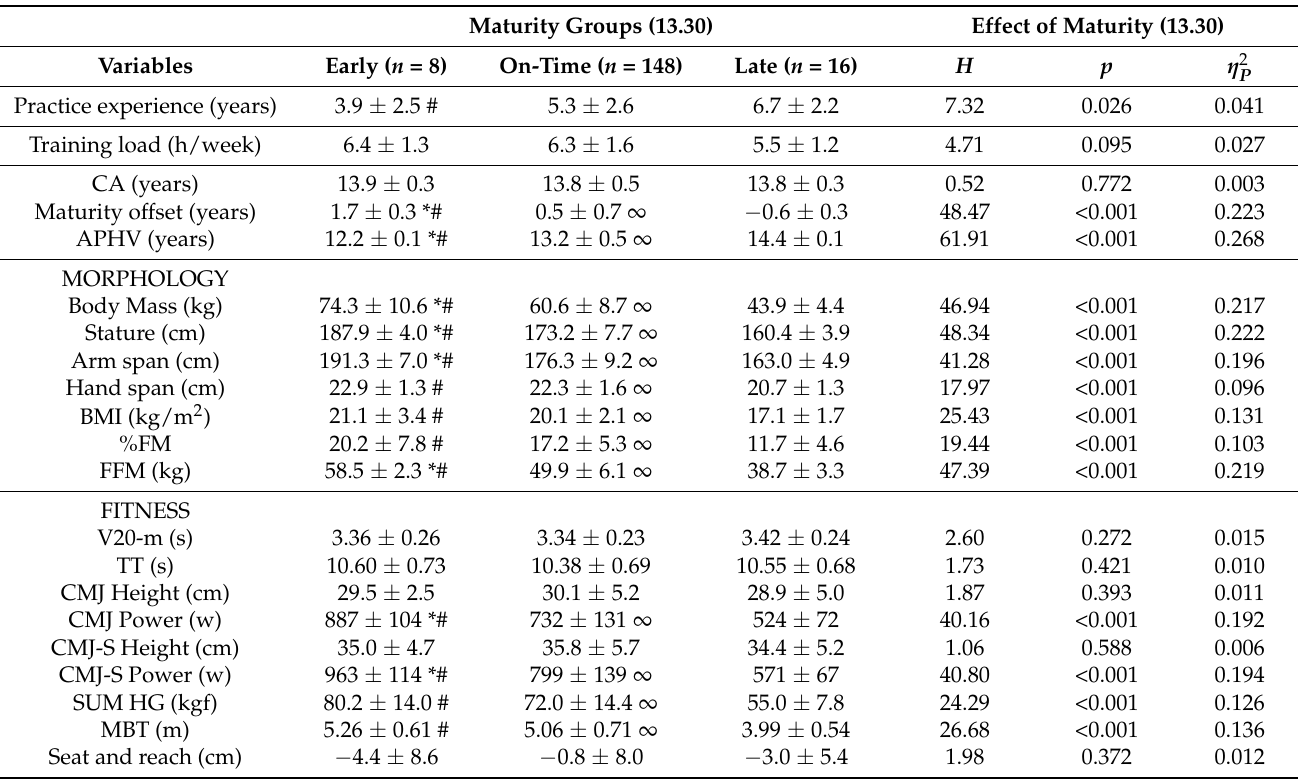
Table 5. Descriptive statistics (mean and standard deviation) and results of Kruskal-Wallis tests to evaluate the effect of maturity group (APHV = 13.30) in U14 basketball players’